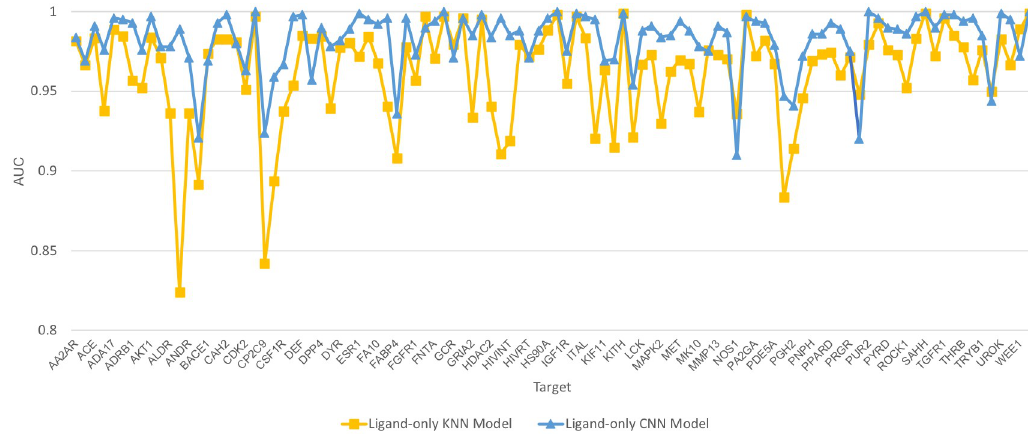
Fig 7. Performance of ligand-trained KNN and CNN models for 102 DUD-E targets.